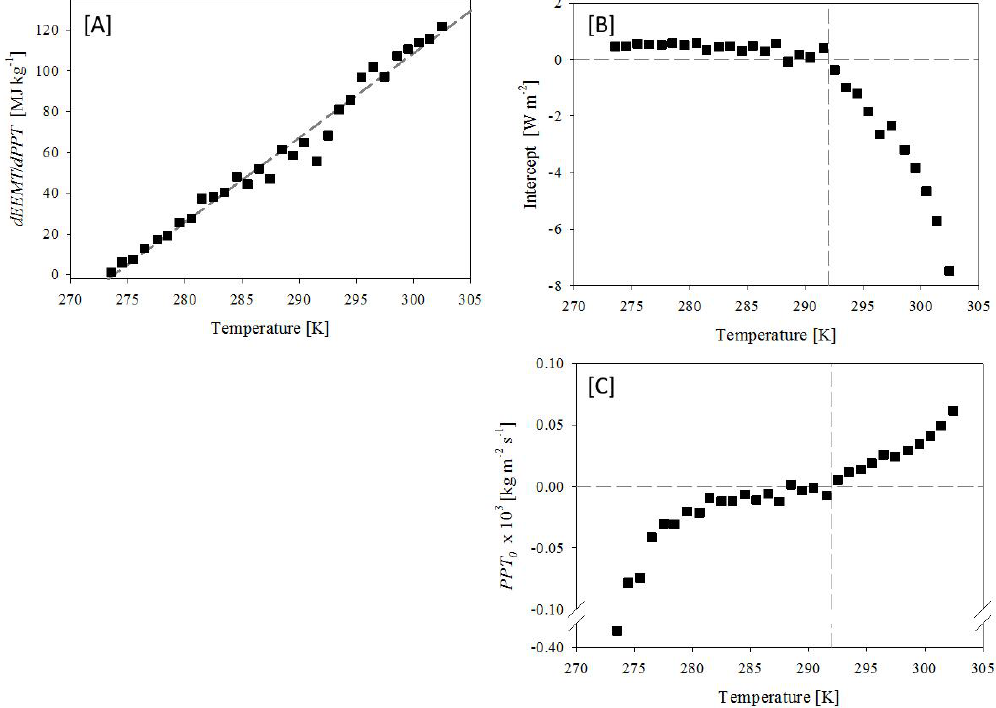
Fig. 5. Linear equation parameters relating effective energy and mass transfer (EEMT) to precipitation for 1 ◦ K temperature bins relative to temperature: (a) slope, (b) y -intercept, (c) intercept/slope equivalent to x -intercept. The dashed lines in (b) and (c) note the break point in Figure 5. Linear equation parameters relating effective energy and mass transfer ( EEMT ) to 782 the functional relationship of the y -intercept and x -intercept relative to temperature. precipitation for 1 degree K temperature bins relative to temperature: (a) slope, (b) y-intercept, (c) 783 intercept/slope equivalent to x-intercept. The dashed lines in (b) and (c) note the break point in 784 the functional relationship of the y-intercept and x-intercept relative to temperature. 785